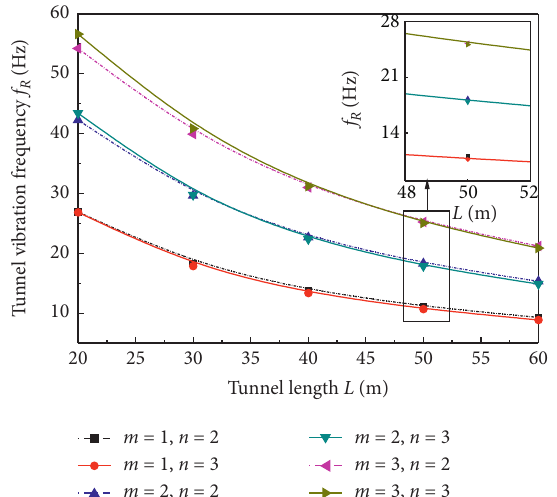
Figure 10: Relationship between natural frequency of the tunnel and the modulus of soil, where η � 1.0 × 10 6 Pa · s.